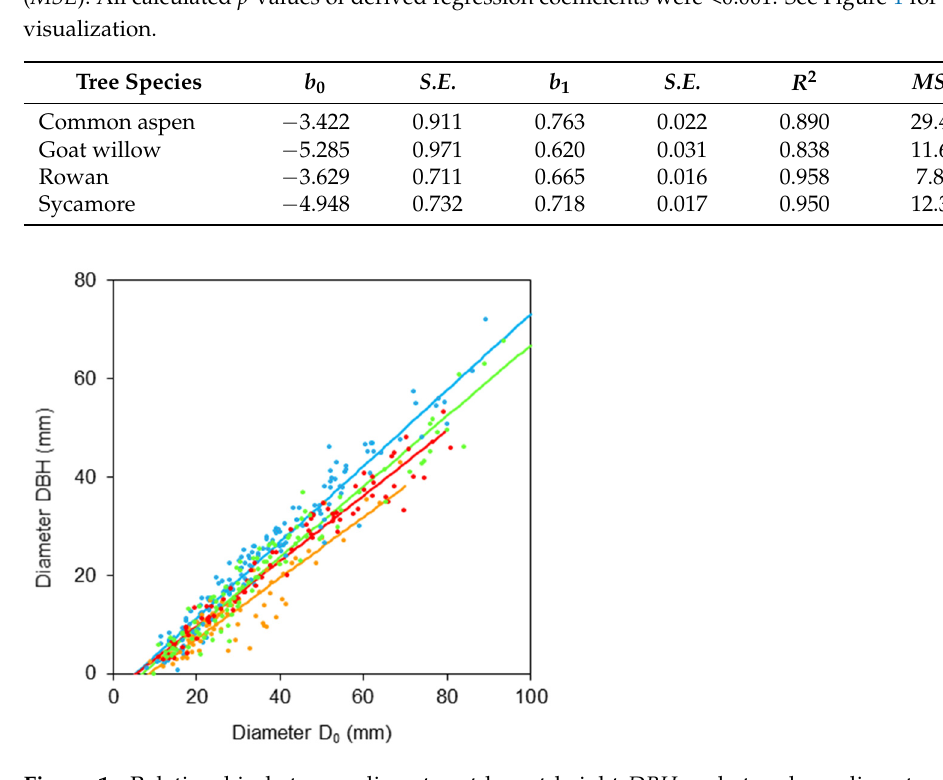
Figure 1. Relationship between diameter at breast height DBH and stem base diameter D 0 for common aspen (blue), goat willow (orange), rowan (red) and sycamore (green), see Table 1 for formula and statistical characteristics. Table 2. Relationship between tree height H and stem base diameter D 0 for four broadleaved tree standard errors ( S.E. ), p -value ( P ), coefficient of determination ( R 2 ), mean squared error ( MSE ). See also Figure 2 for model visualization.